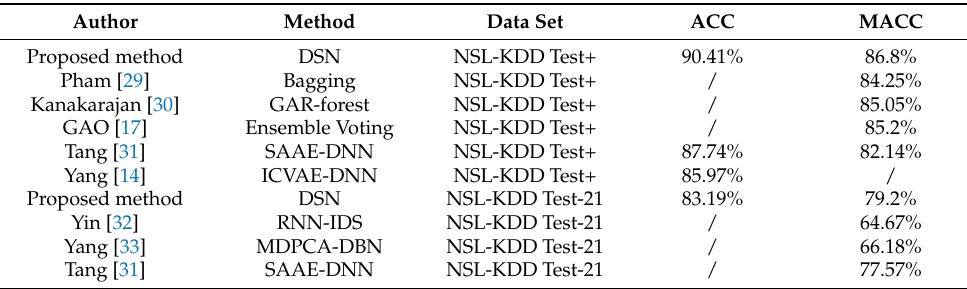
Table 8. Comparison results based on